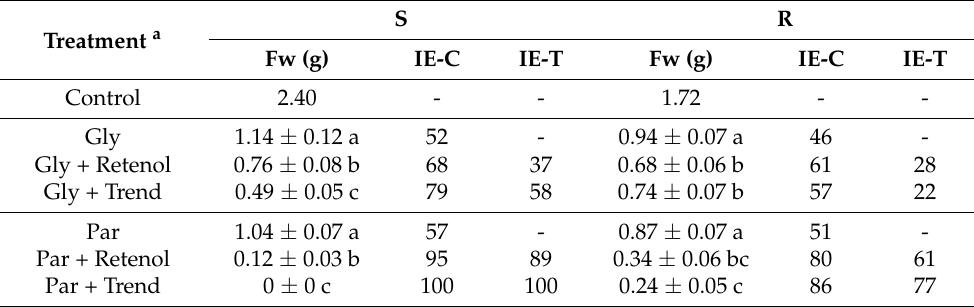
a Herbicide doses applied were the corresponding GR 50 values determined for each population and herbicide. Different letters per column refer to treatments that are significantly different based on the Tukey test at the 95% probability. Mean values ± standard errors of the mean ( n =